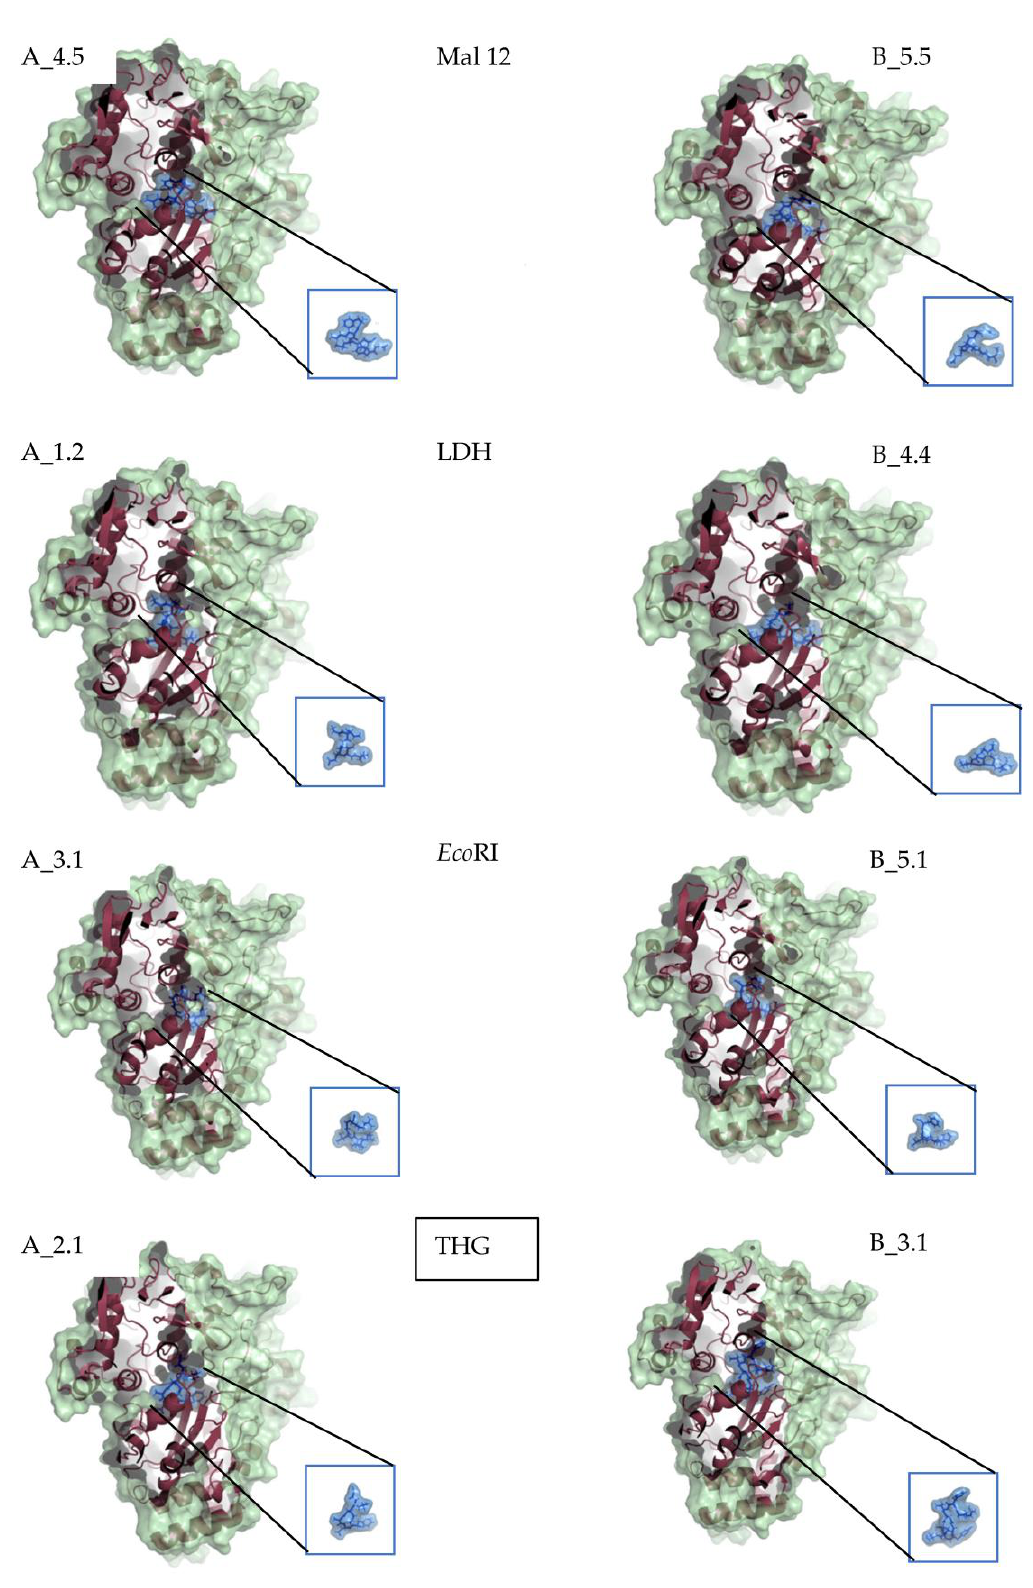
Figure 3. Positions of the best conformations of the two outstanding ligands of Mal12, LDH, Eco RI and THG. The colors in the OppA region indicate its surface shape (green), the ribbon representation of the protein (red) and the ligand (blue).